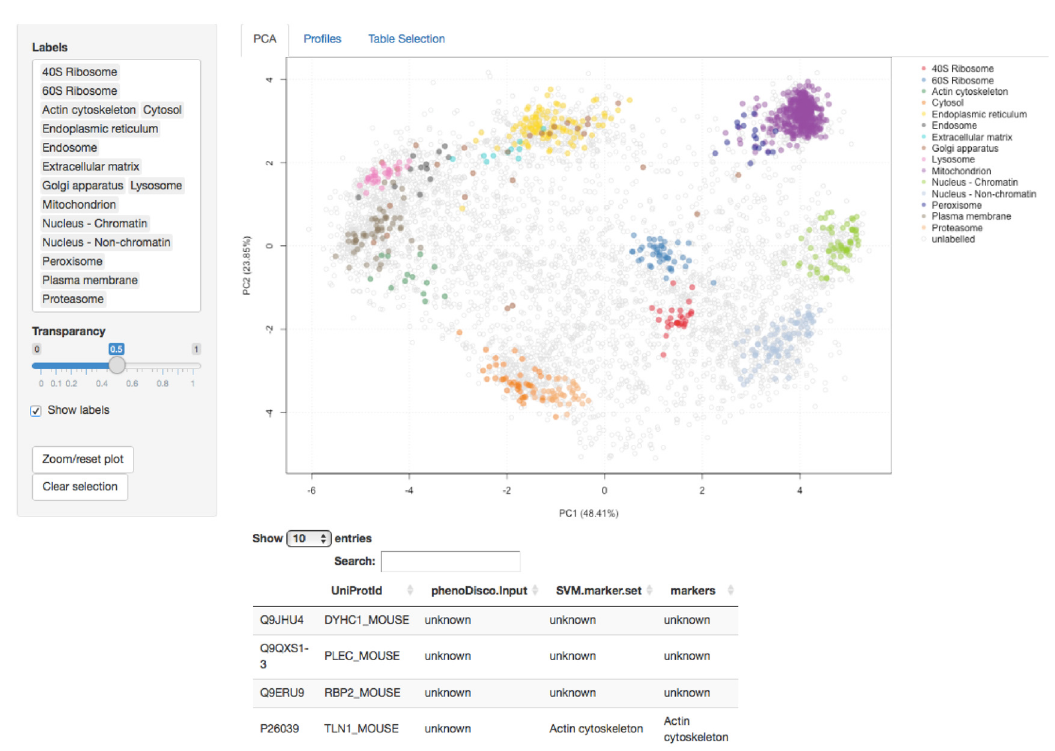
Figure 12. A screen shot of clickable interface and zoomable PCA plot of the main app in the pRolocGUI package.